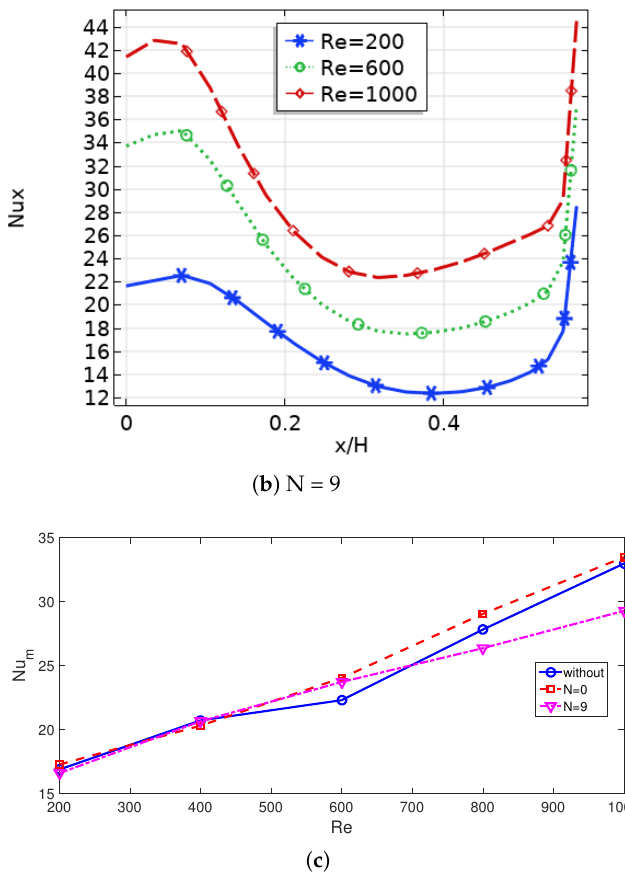
Figure 7. Local ( a , b ) and average ( c ) Nu variations with different Re for different cases of using PPs (Ha = 15, Ca = 10 − 5 , Da = 10 − 2